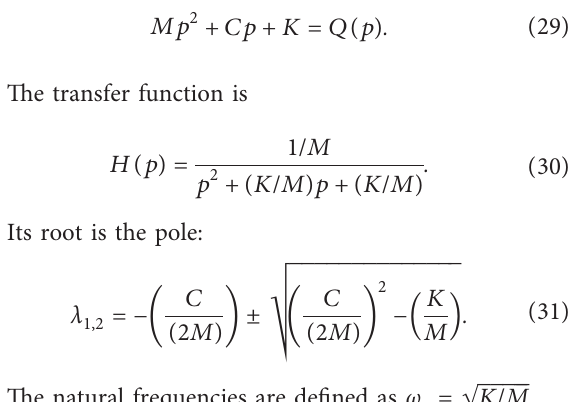
and K ( φ F � 90 o 0